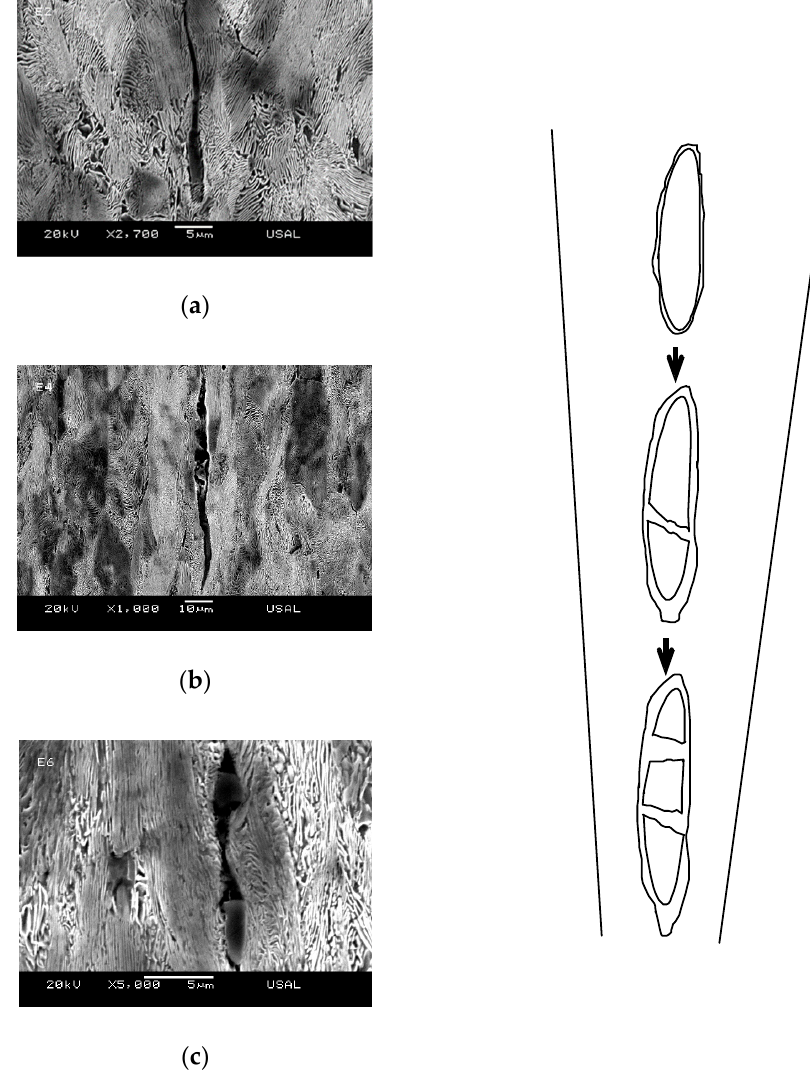
Figure 12. Micrographs and outline of the evolution of the inclusions of the soft-type during the drawing process belonging to the steels E2 ( a ), E4 ( b ) and E6 ( c ). Mix -type inclusions are made up of two typologies of inclusions, one softer and one harder. Both typologies, within the same inclusion, are clearly different by tonality and shape; the hard -type inclusion being darker and with a rounded morphology. A multitude of mix -type inclusions was observed in the steels studied. In the following diagram —and micrographs (Figure 13)—it is shown how the hardest inclusion appears in the central area of the mix -type inclusion, while its periphery is formed by a softer inclusion (of lighter tonality). The microcavity generated from this type of inclusion has a slenderness similar to that generated by the soft -type inclusion. The width of this microdamage is greater than that created by soft -type inclusion, since the inclusion of hard -type existing in the core of the mix -type inclusions is barely deformed transversely throughout the drawing process. The soft outer part of the mix -type inclusion is deformed during the first steps of the drawing process in the direction of the conformation process itself (longitudinal axis of the wire). As this process grows, the soft part of the inclusion can become fragmented forming empty spaces between the different fragments created during drawing. Once the soft part of the mix -type inclusion is fragmented, due to the constraint of the colonies dur- ing drawing, this area can be filled with the surrounding pearlitic matrix thanks to the